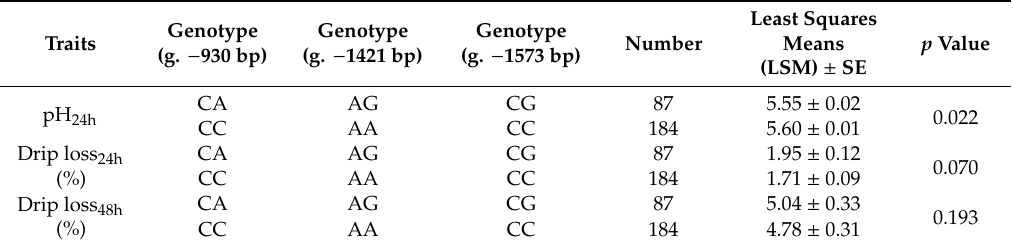
Table 3. Association analysis of SNPs polymorphisms with porcine production